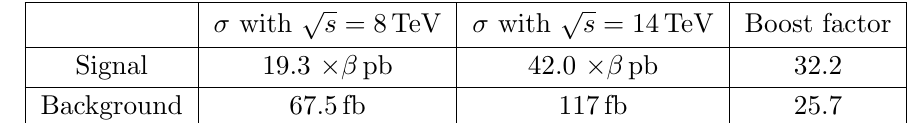
Table 6. The projected LHC sensitivity at 14 TeV is given, where (cid:12) = BR( H ! hh )BR 2 ( h ! (cid:13)(cid:13) ), expressed in terms of the boost factor, de(cid:12)ned as (cid:27) ( be 300/fb and L 8TeV is taken as